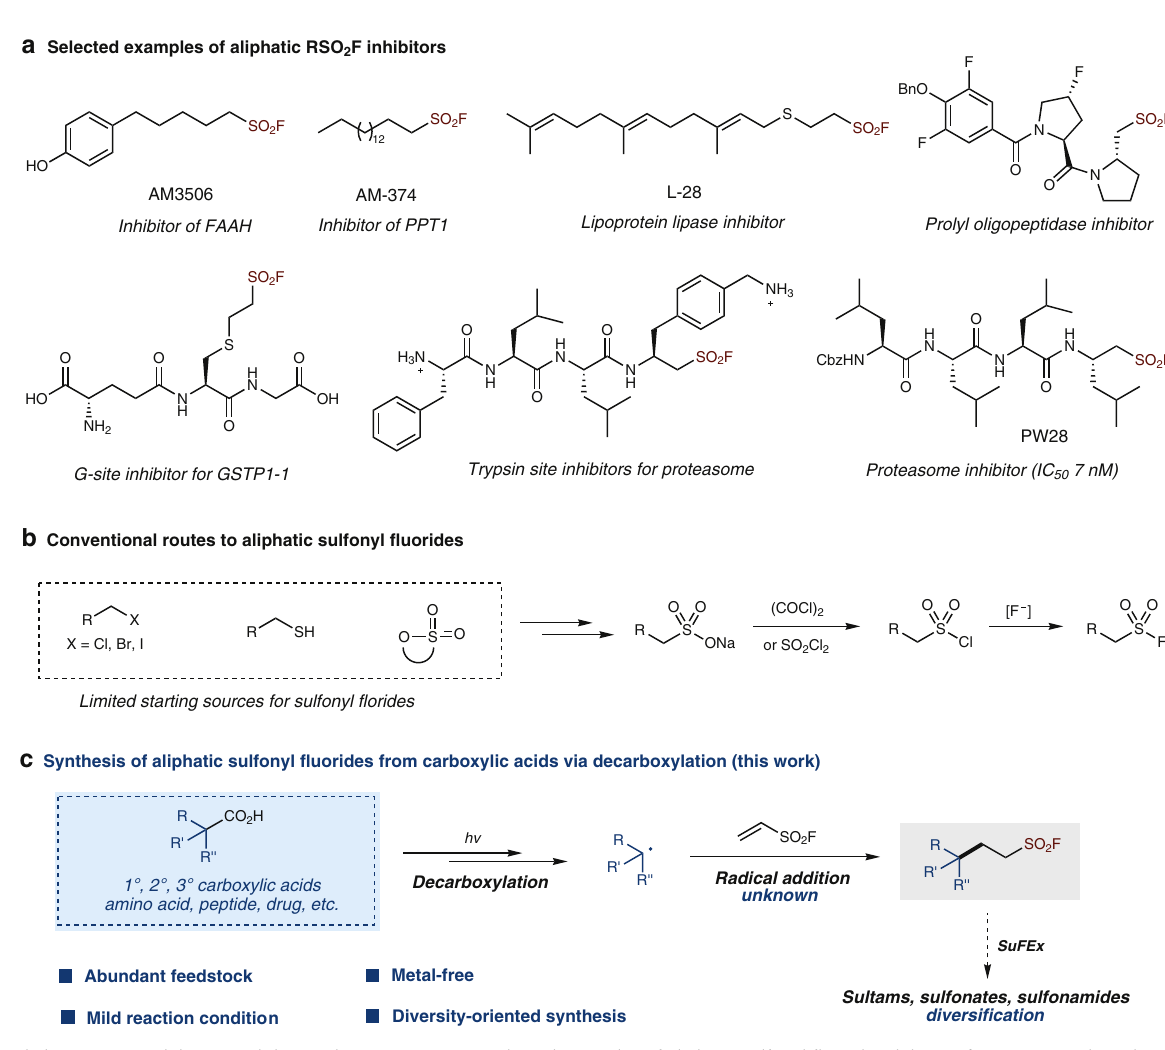
Fig. 1 Aliphatic RSO 2 F inhibitors and the synthetic strategies. a Selected examples of aliphatic sulfonyl fl uoride inhibitors. b Conventional synthetic routes to aliphatic sulfonyl fl uorides. c Synthesis of aliphatic sulfonyl fl uorides from carboxylic acids via visible-light-mediated decarboxylation (this